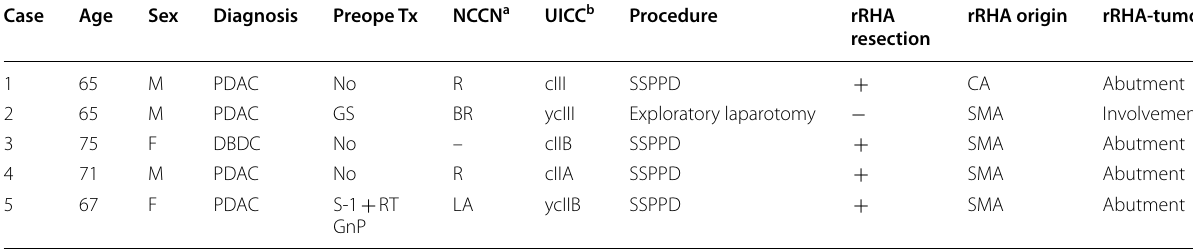
rRHA replaced right hepatic artery; PDAC pancreatic ductal adenocarcinoma; DBDC distal bile duct cancer; PreopeTx preoperative therapy; GS gemcitabine RT radiation; GnP